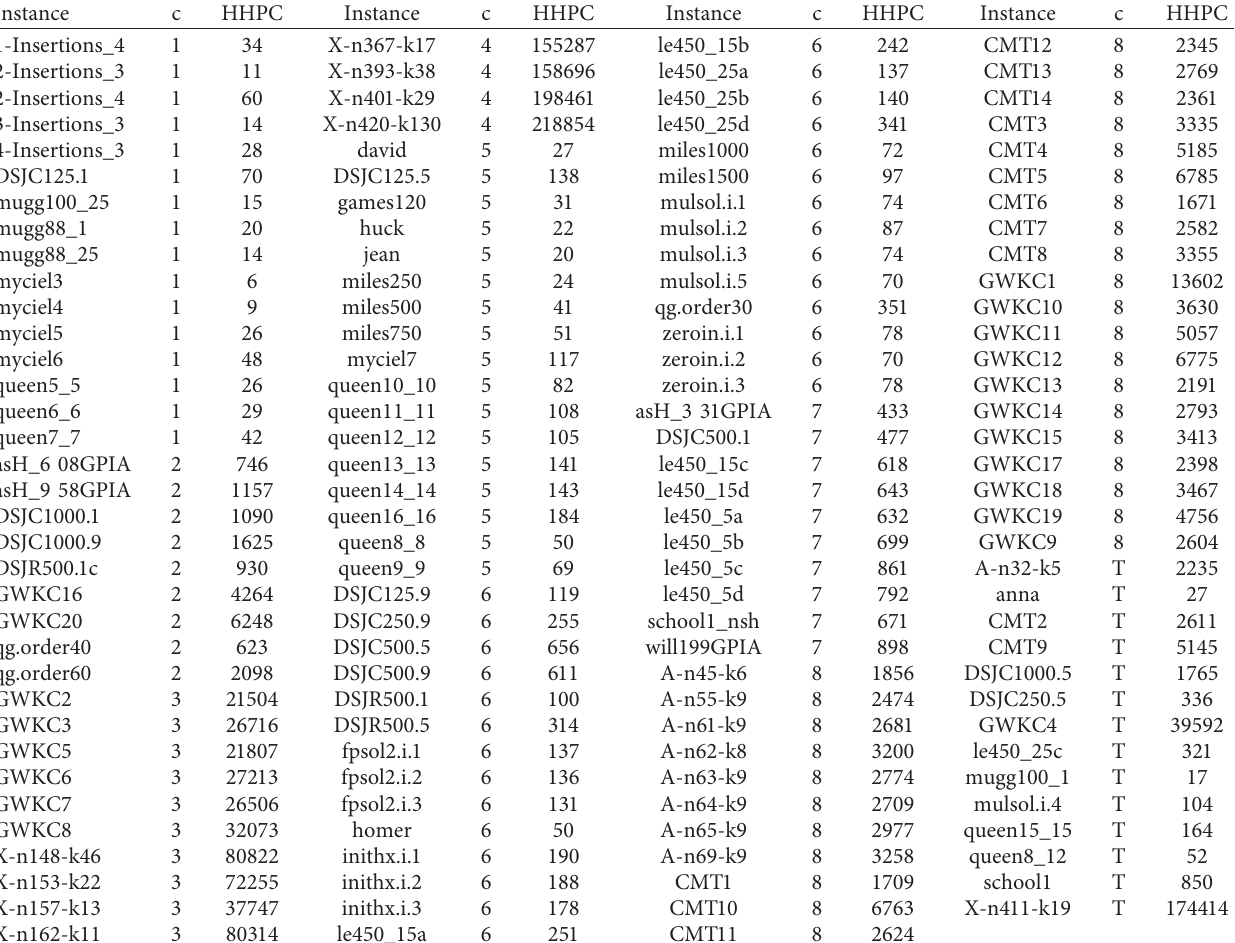
Table 19: Results of hyperheuristic with the complete set heuristics and without methodology (HHPC), cluster (C), and T which are the training set instances.